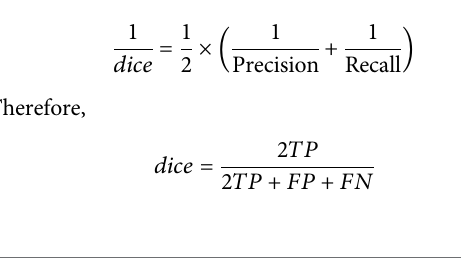
Frontiers in Earth Science |